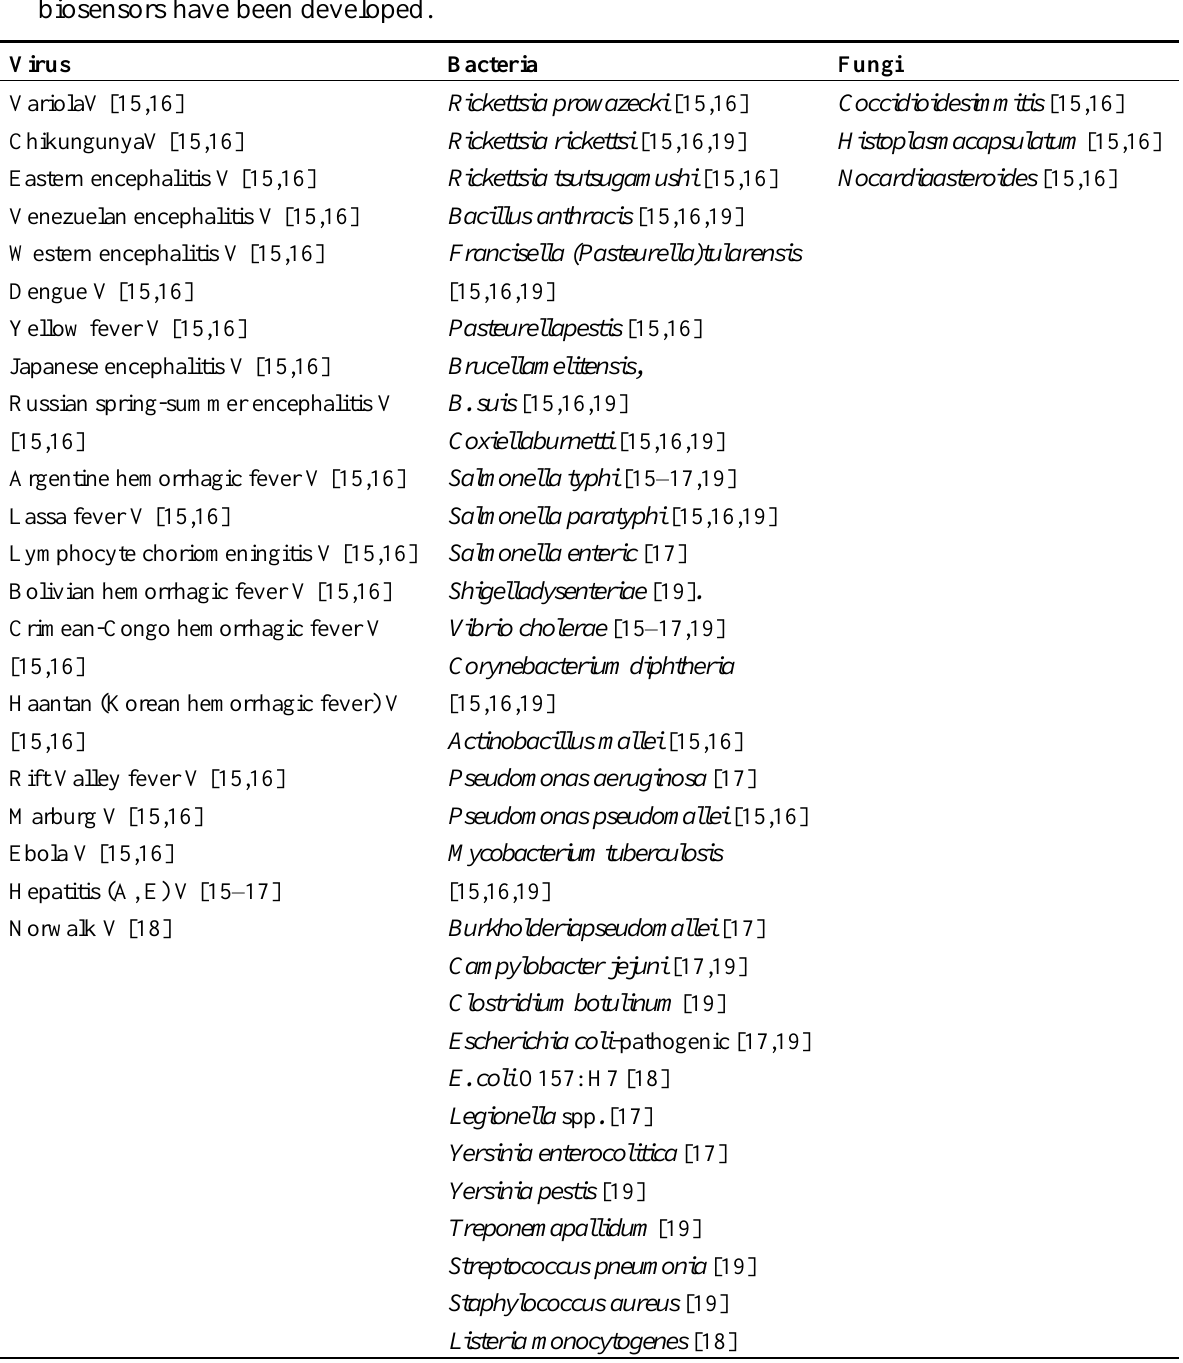
Table 1. Summary of pathogenic organisms relevant to clinical diagnostics for which biosensors have been